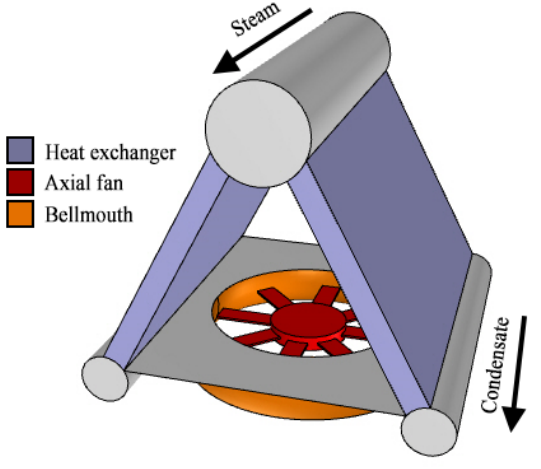
Figure 1. A-frame arrangement for an ACC unit .